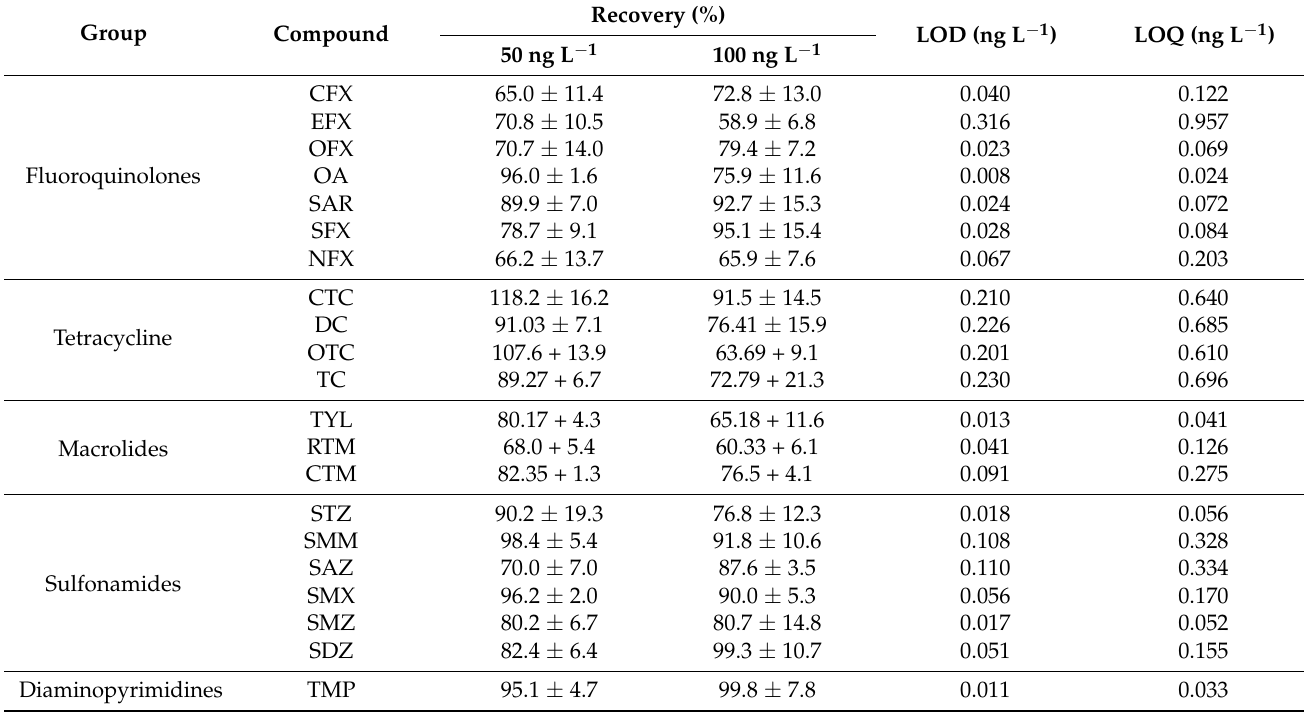
Table A2. Description of recovery, limits of quantification (LOQ) and detection